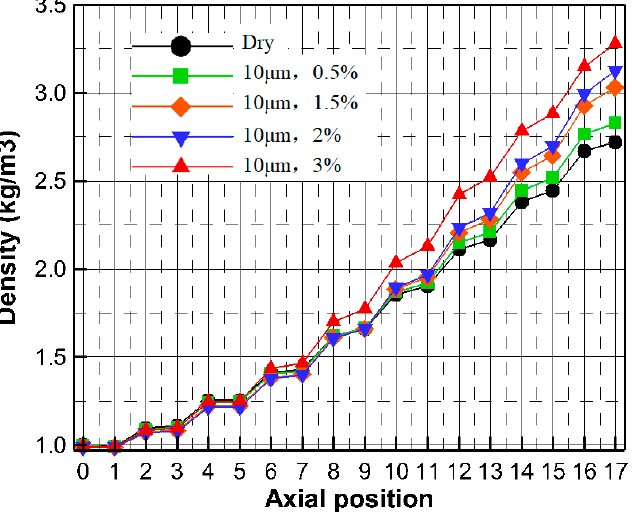
Figure 32. Axial variation of gas density under water of different injecting rates.